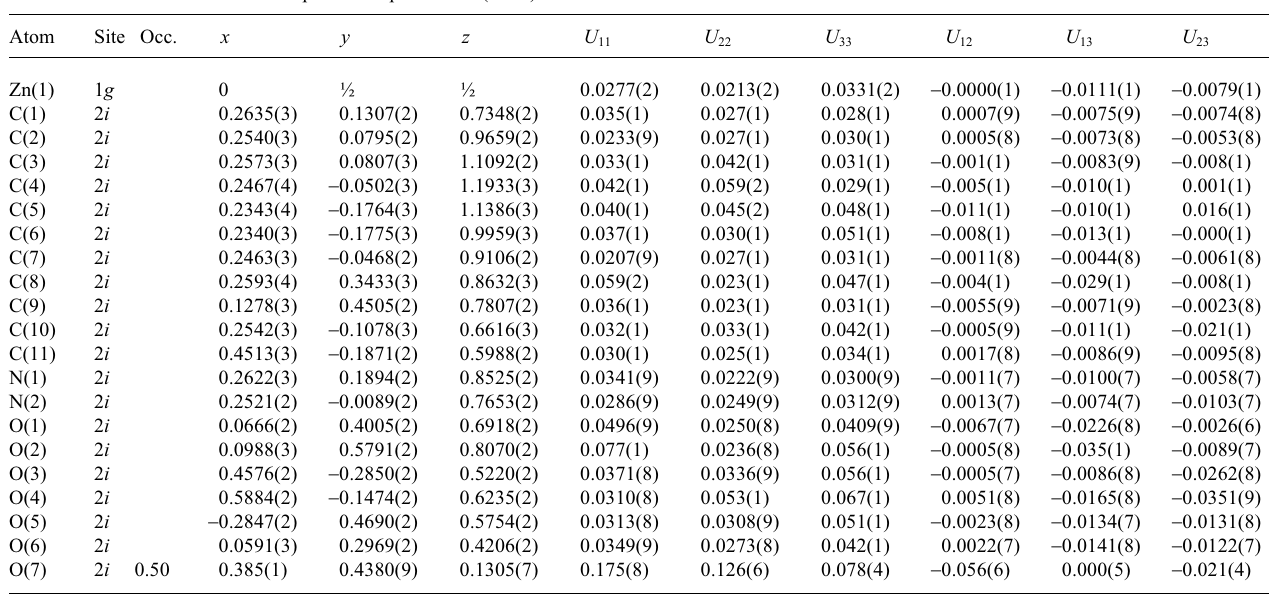
Table 3. Atomic coordinates and displacement parameters (in Å 2 ).